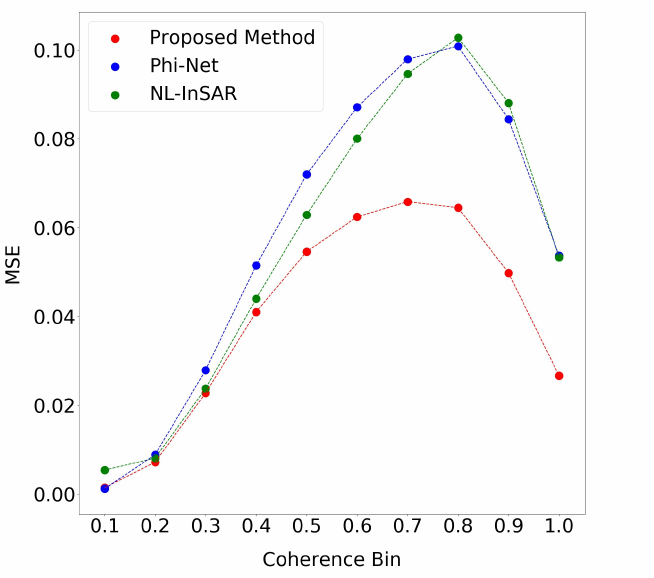
Figure 16. Coherence performance evaluation: mean square error for all methods under